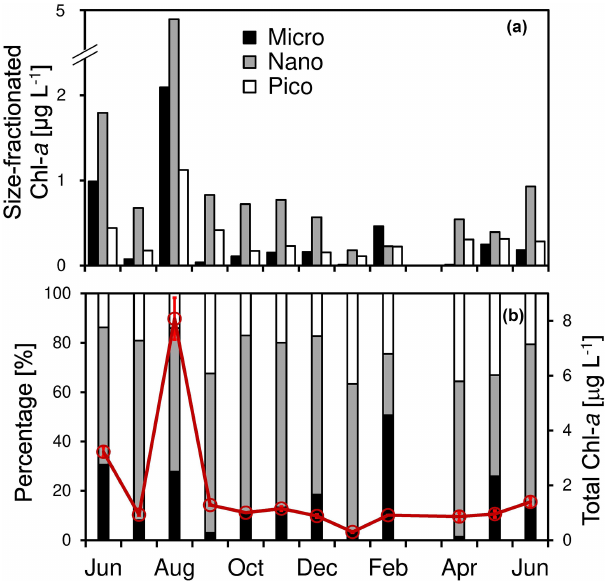
Figure 3. Temporal change of (a) size-fractionated chlorophyll a concentrations of micro-, nano-, and pico-phytoplankton as well as (b) the total chlorophyll a concentration (red circles and lines) and the size-fractionated percentages (columns) at the Wanshan station from June 2018 to June 2019. Error bars are standard